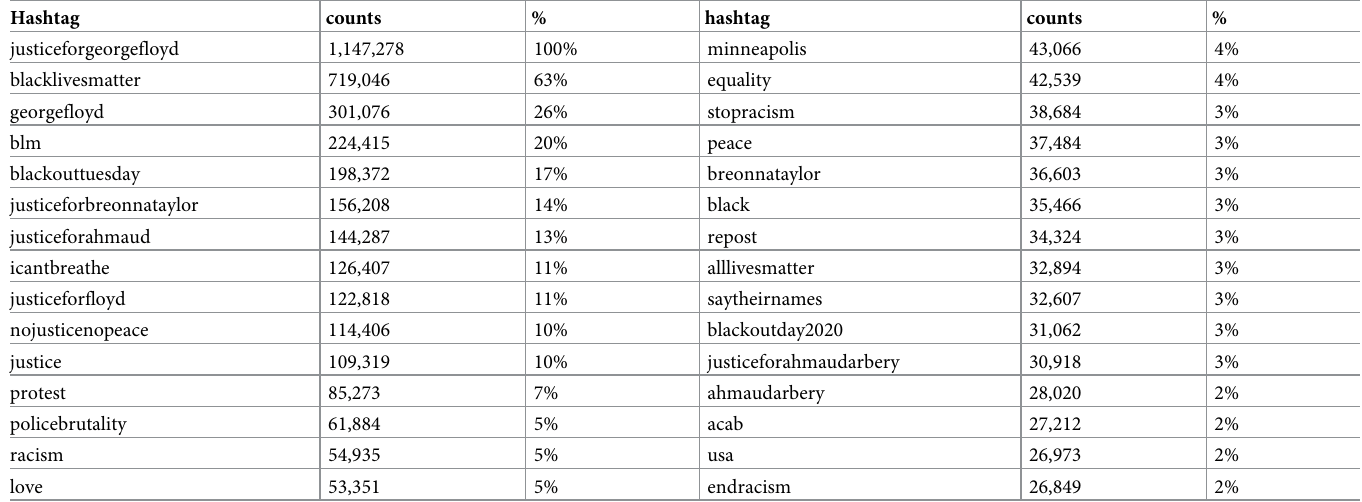
Table 2. Top hashtags of 540,591 unique